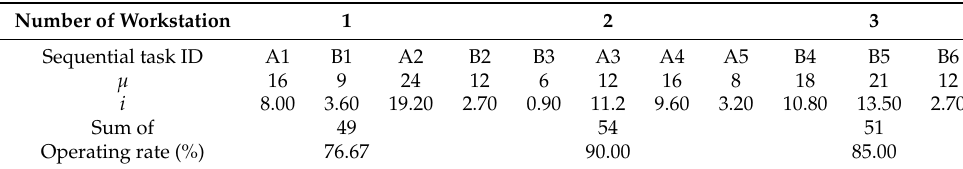
Table 5. A feasible disassembly sequence of the